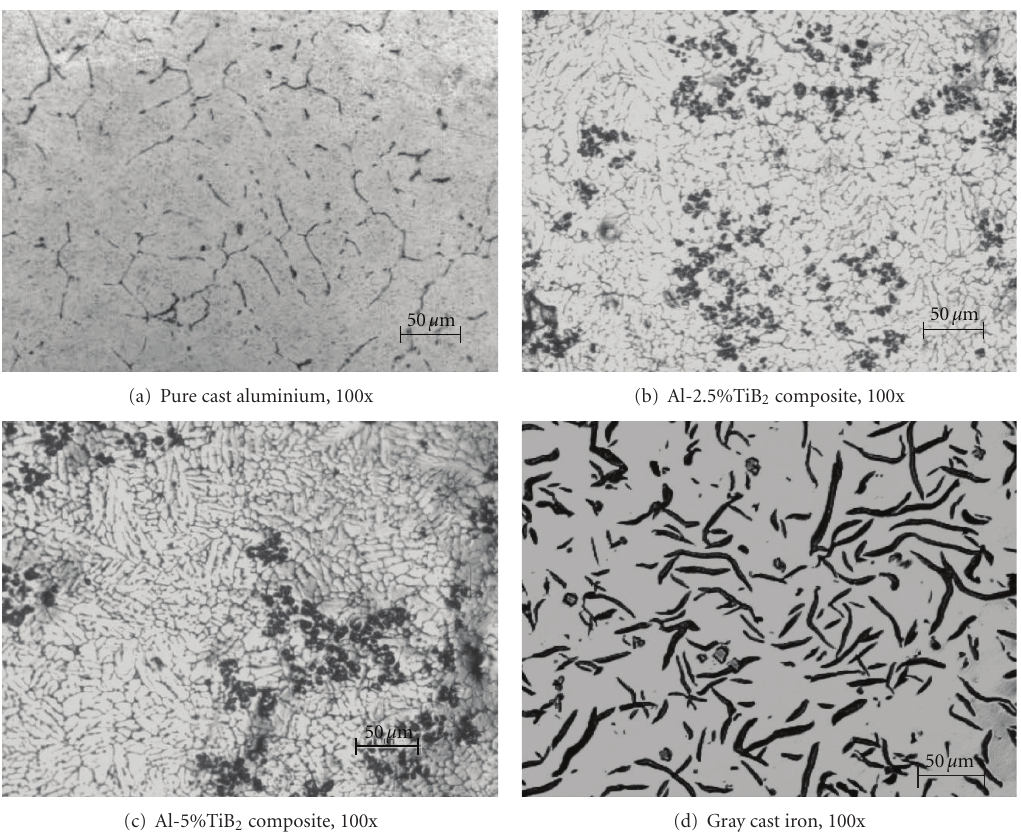
Figure 2: Optical micrographs of cast aluminium, Al-2.5%TiB 2 Al-5%TiB 2 composite and gray cast